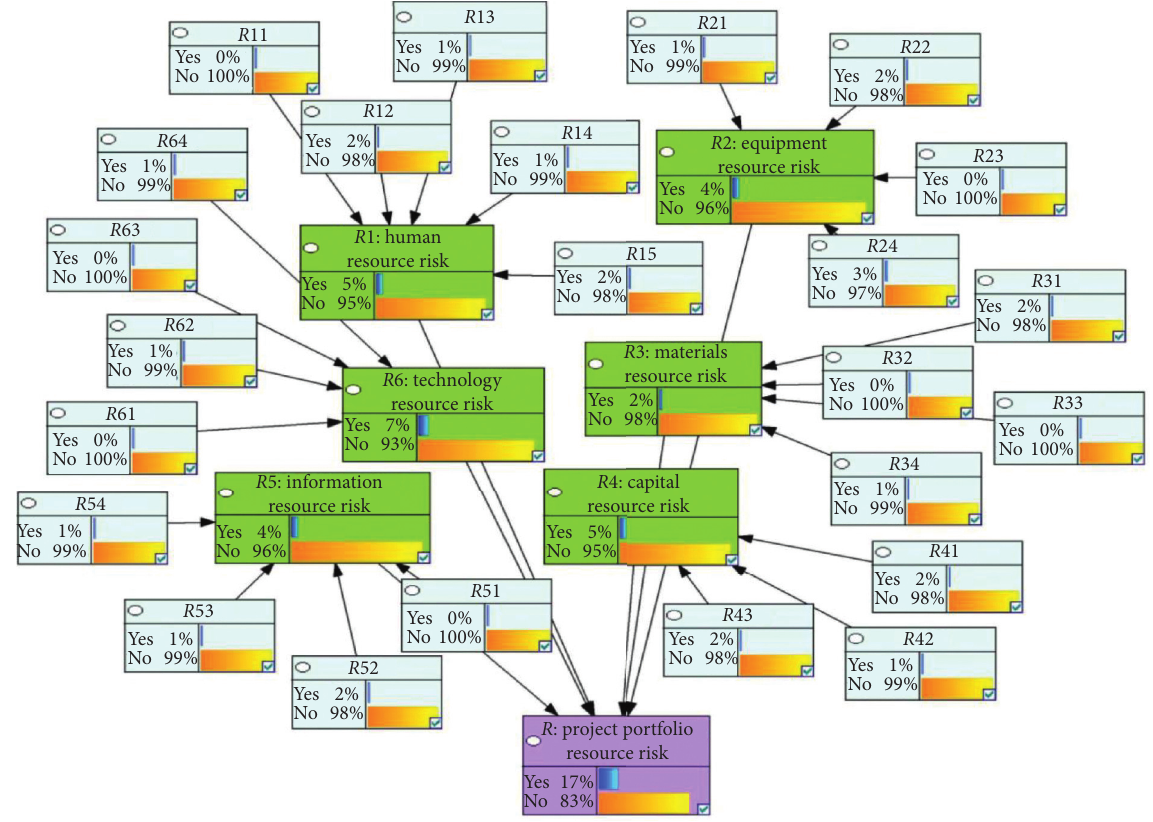
Figure 3: Forward propagation analysis of the project portfolio resource